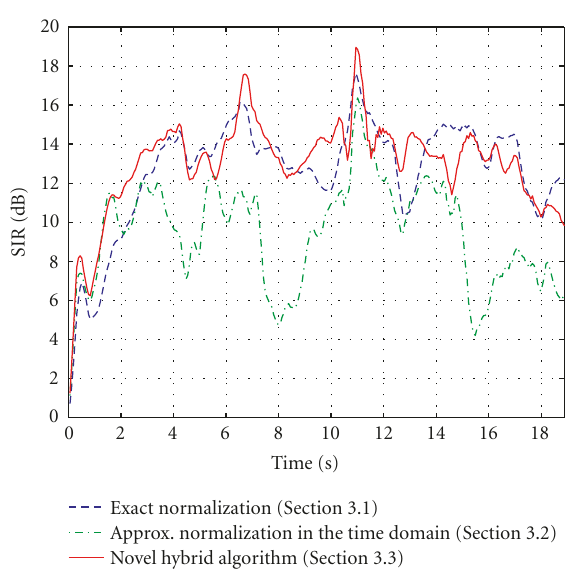
Novel hybrid algorithm (Section 3.3) Figure 3: SIR results for car environment (0dB car